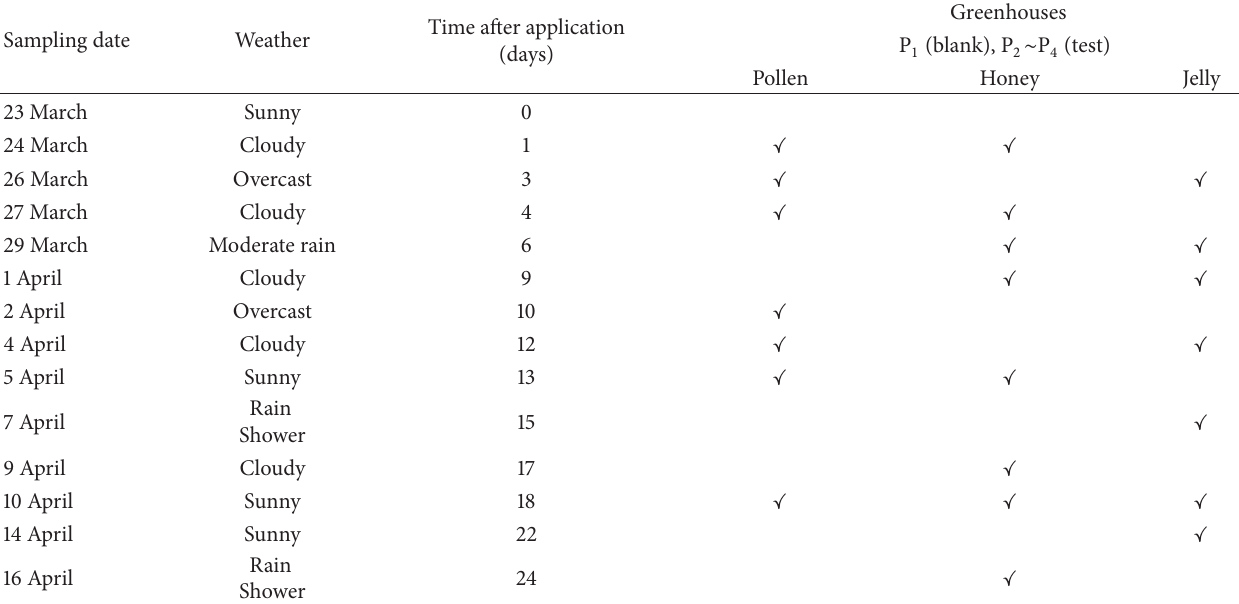
Table 1: Sampling table of field